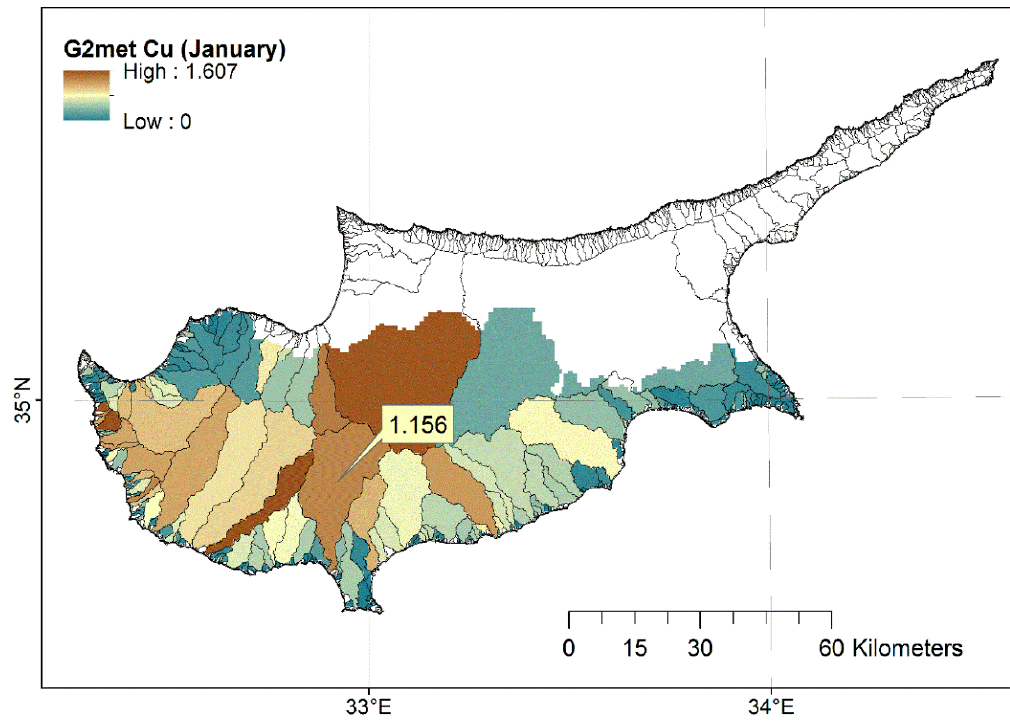
Figure 10. Choropleth map of the mean G2 met index values for Cu per basin in January (value ranging: histogram equalization; indicative example of Kouris basin, 1.156).